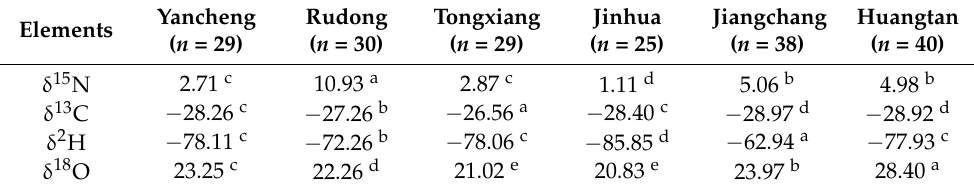
Table 1. Mean values of N, C, H, and O stable isotopes of HBJ flower from different origins.